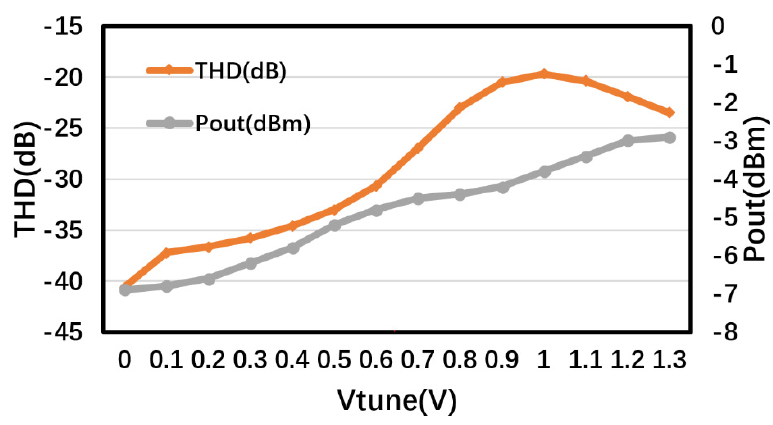
Figure 11. THD and output power vs. tuning range.